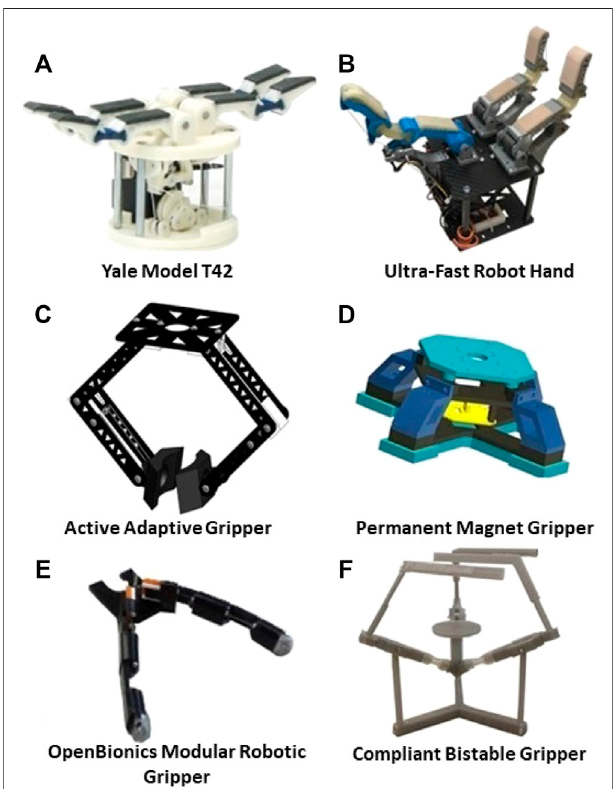
FIGURE 3 | Grippers for aerial grasping: (A) is the Yale Model T42 (Yale OpenHandProject-ModelT,2019)whichispresentedin Section.2.1.1 , (B) is the New Dexterity Ultra-Fast Robot Hand (New Dexterity Aerial Grasping Gripper, 2019) which is presented in Section. 2.1.3 , (C) is an Actively Adaptive Gripper (Kruse and Bradley, 2018) which is presented in Section. 2.1.4 , (D) isaPermanentMagnetGripper(Fiazetal.,2018)whichispresented in Section. 2.1.5 , (E) is the OpenBionics Modular Robotic Gripper (Zisimatos et al., 2014) which is presented in Section. 2.1.2 , and (F) is a Compliant Bistable Gripper (Zhang H. et al., 2019) which is presented in Section. 2.1.6 .